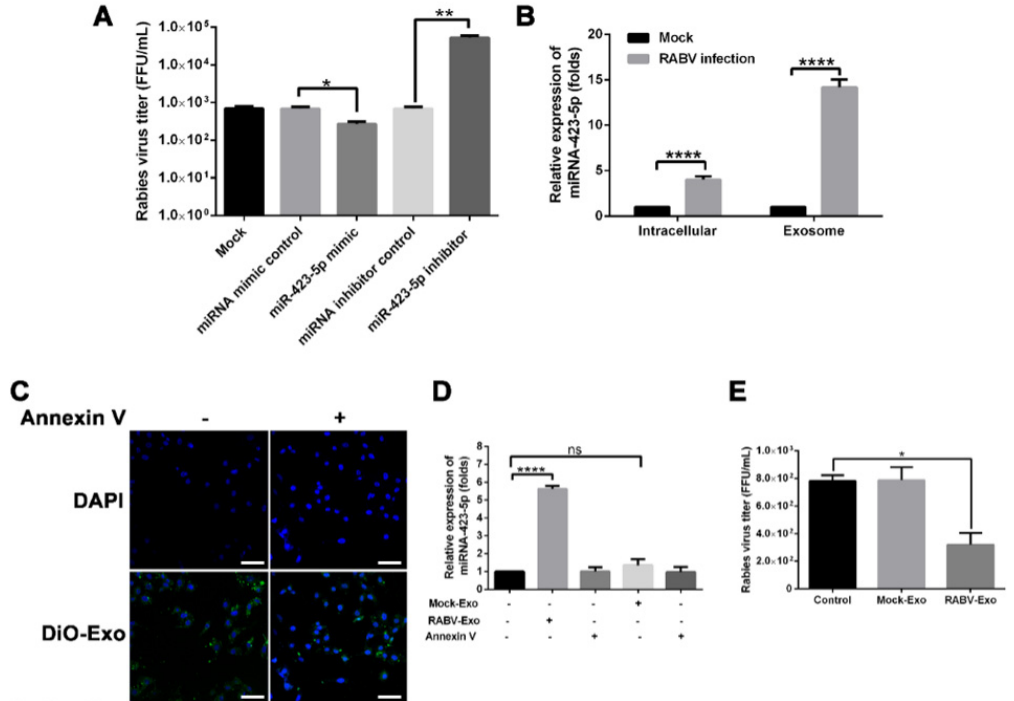
Figure 4. MicroRNA (miR)-423-5p feedback inhibits rabies virus (RABV) replication in MRC-5 cells. ( A ) MRC-5 cells were transfected with 100 nmol/L miR-423-5p mimic, miRNA mimic control, miR-423-5p inhibitor, or miRNA inhibitor control for 24 h, and the culture medium was replaced by fresh media containing RABV (multiplicity of infection (MOI) = 1). At 48 h post infection, the viral titer was determined using quantitative reverse transcriptase PCR (qRT-PCR). ( B ) qRT-PCR analysis of miR-423-5p expression in intracellular compartments or purified exosomes of MRC-5 cells with or without RABV infection for 24 h. ( C ) Exosomes from RABV-infected MRC-5 cell culture supernatants (RABV-Exo) were labeled with DiO dye, incubated with MRC-5 cells for 20 min, and visualized using fluorescence confocal microscopy. The annexin V-treated groups were pre-incubated for 2 h with annexin V (2 µg/mL). Scale bar = 50 µm. ( D ) qRT-PCR analysis of miR-423-5p levels in the recipient MRC-5 cells. Uninfected MRC-5 cells were incubated with purified exosomes from uninfected MRC-5 cells (Mock-Exo) or RABV-infected cells (RABV-Exo) in the presence or absence of annexin V. At 24 h post incubation, the miR-423-5p expression levels were determined. ( E ) MRC-5 cells were